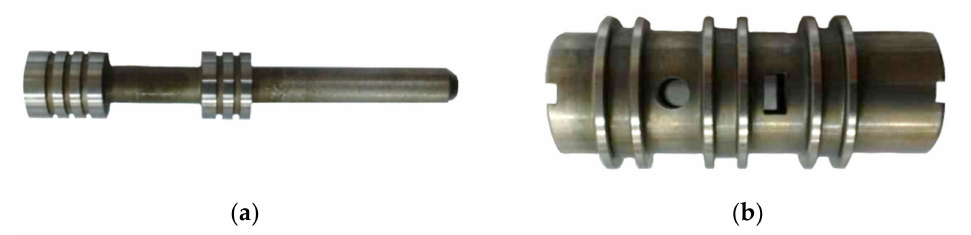
Figure 6. Manufactured spool and sleeve part: ( a ) spool, ( b )